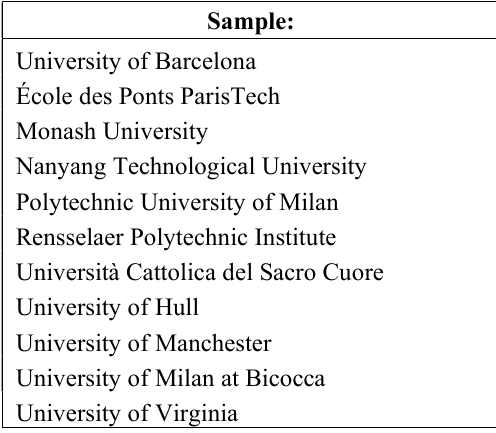
Table 1. Universities that have been selected for this analysis Sample: